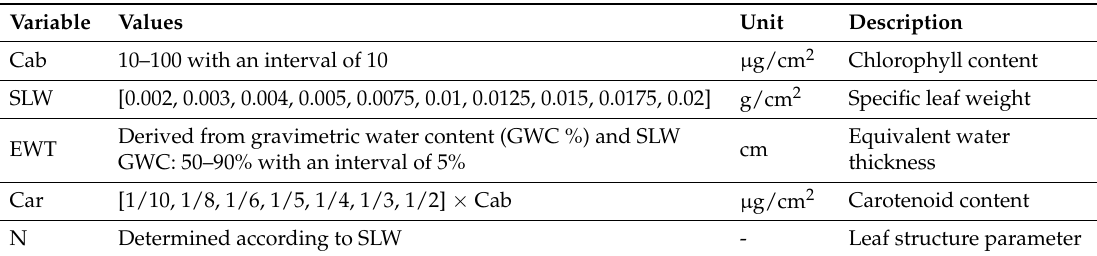
Table 1. Inputs to the PROSPECT model used in the simulation